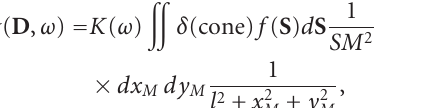
Figure 5: Principle of a Compton